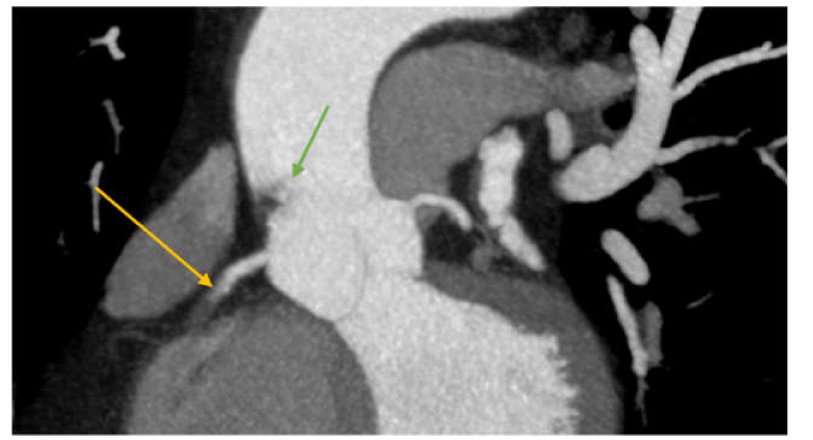
Figure 5. CTA image showing right coronary artery obstruction (yellow arrow) and the endoluminal thrombus (filling defect in the ascending aorta—green arrow).